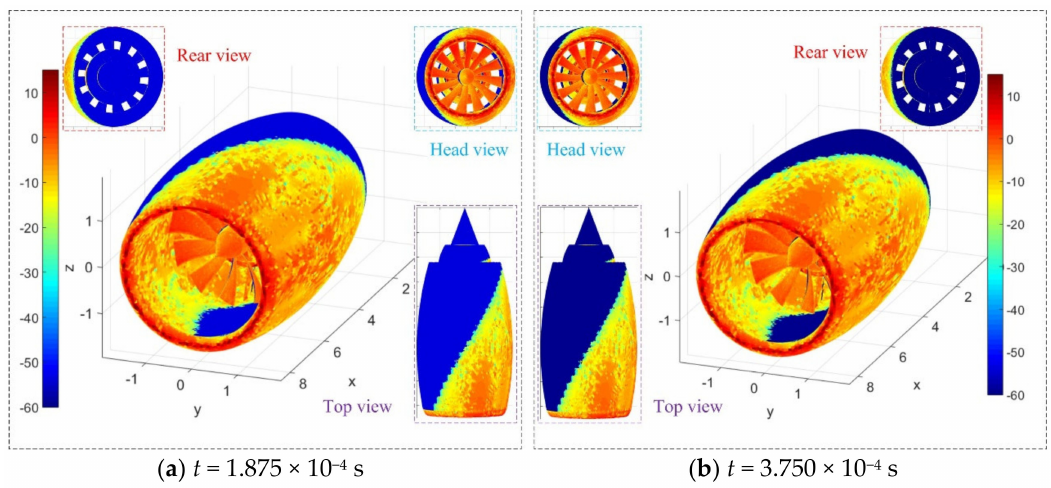
Figure 16. Surface electromagnetic scattering characteristics of m engine , α = 20 ◦ and β = 0 ◦ ; RCS unit: dBm 2